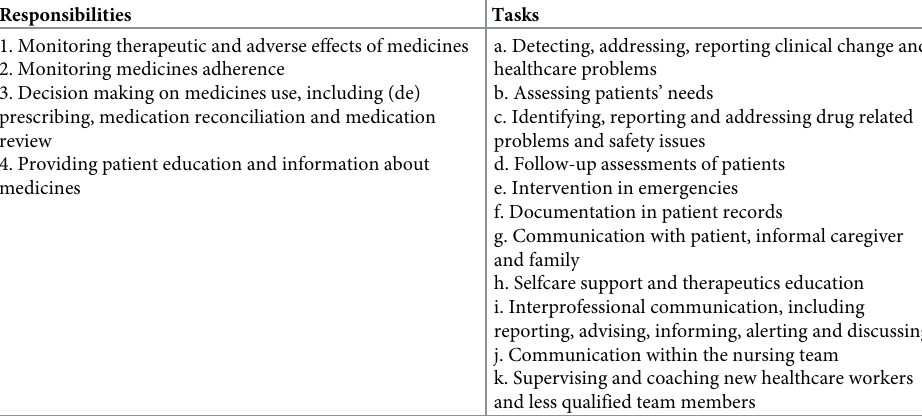
Table 2. Existing or potential nurse responsibilities and tasks in interprofessional pharmaceutical care (beyond medication preparation and administration).